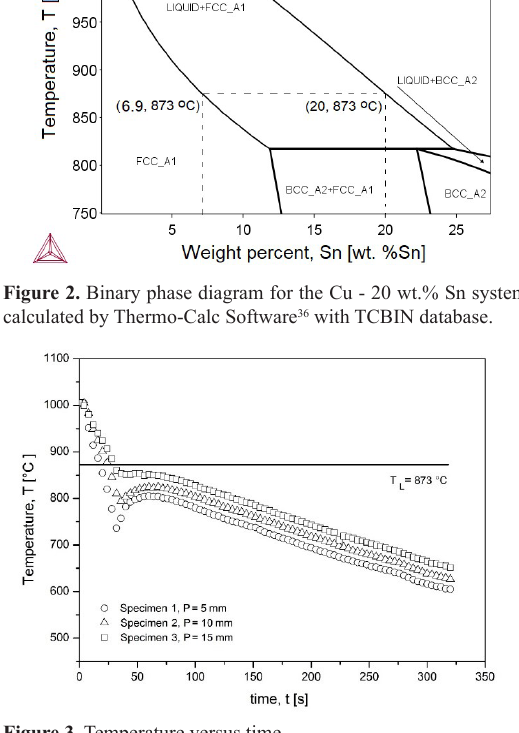
Figure 3. Temperature versus time.